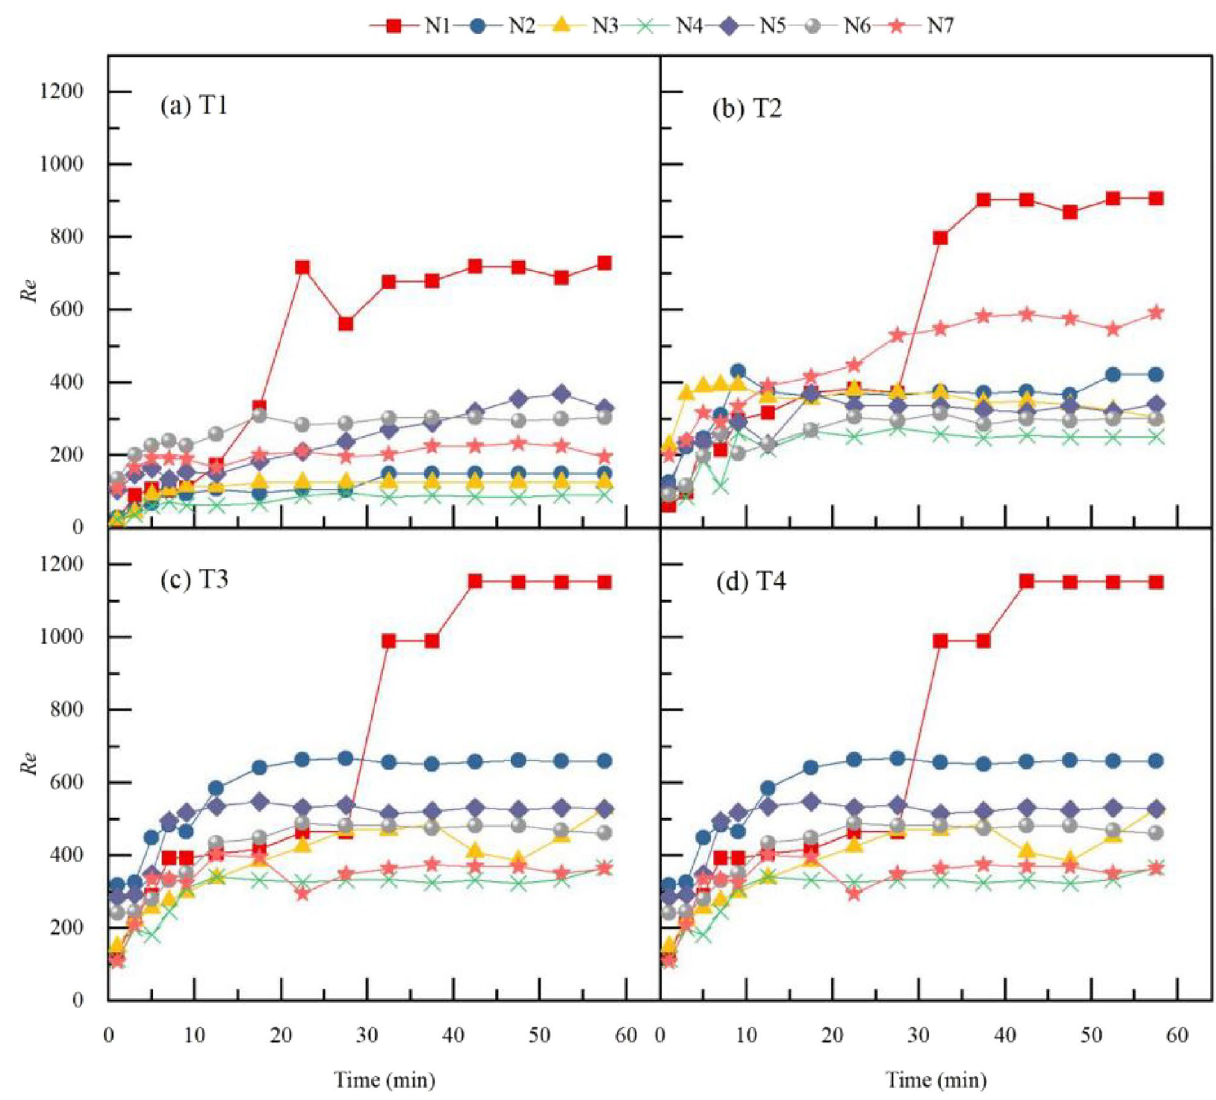
Figure 4. Time series of Reynolds number Re for seven types of litter layer. Re is the Reynolds number of the water flow; N1–N7 are treatments, see Table 2 for treatment specifics. T1 is slope 5°, rain intensity 60 mm·h −1 ; T2 is slope 10°, rain intensity 60 mm·h −1 ; T3 is slope 5°, rain intensity 120 mm·h −1 ; T4 is slope 10°, rain intensity 120 mm·h −1